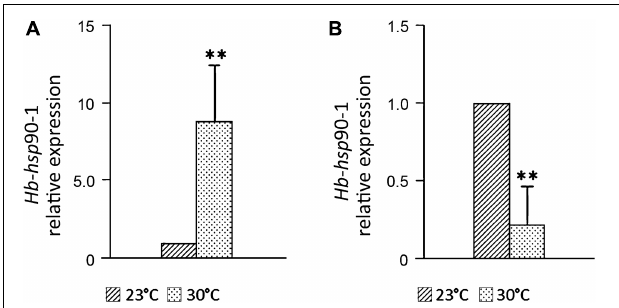
FIGURE 6 | Expression profiles of the Hb - hsp 90-1 of Heterorhabditis bacteriophora at 30 ◦ C in Infective Juveniles (IJ), (A) and adults (B) during parasitic development. Bars indicate standard error of mean data ( n = 3). Significant differences (** P < 0.05) were found between temperature control and higher temperature. FIGURE 7 | Expression of Hb - hsp 90-1 in Infective Juveniles (IJs) of